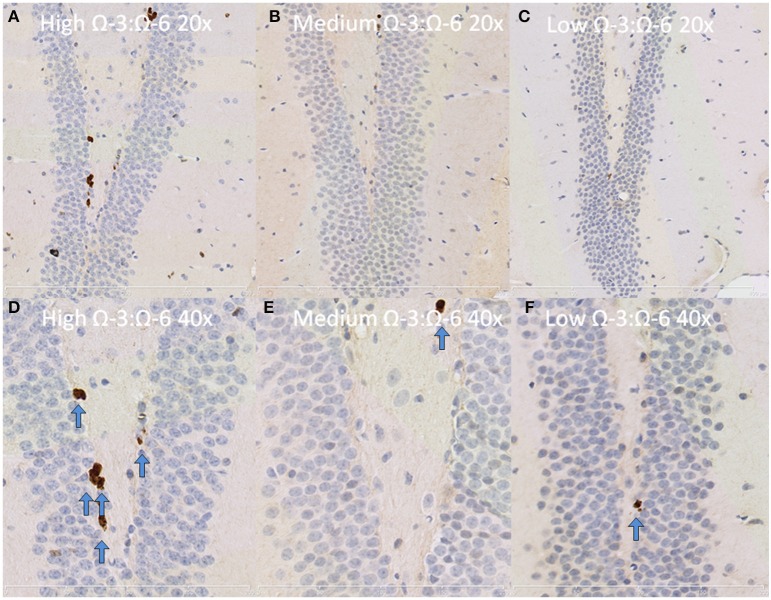
Representative images of Ki67 expression in the dentate gyrus. Representative images of the hippocampus centered on the dentate gyrus to demonstrate expression of Ki67 positive cells at 20× magnification in (A) high Ω-3:Ω-6 mice, (B) medium Ω-3:Ω-6 mice, (C) low Ω-3:Ω-6 mice and at 40× magnification in (D–F), respectively. Arrows signify relevant stained cells.